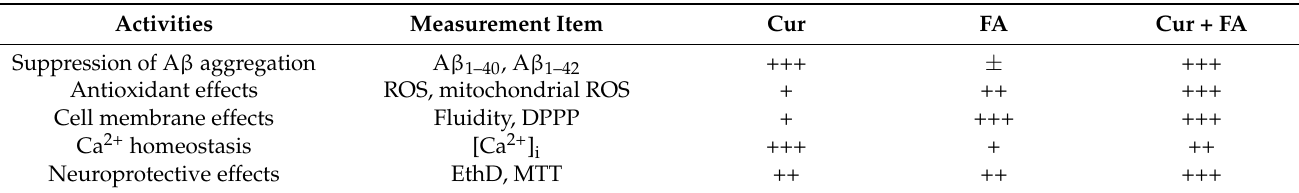
Table 1. Pharmacological